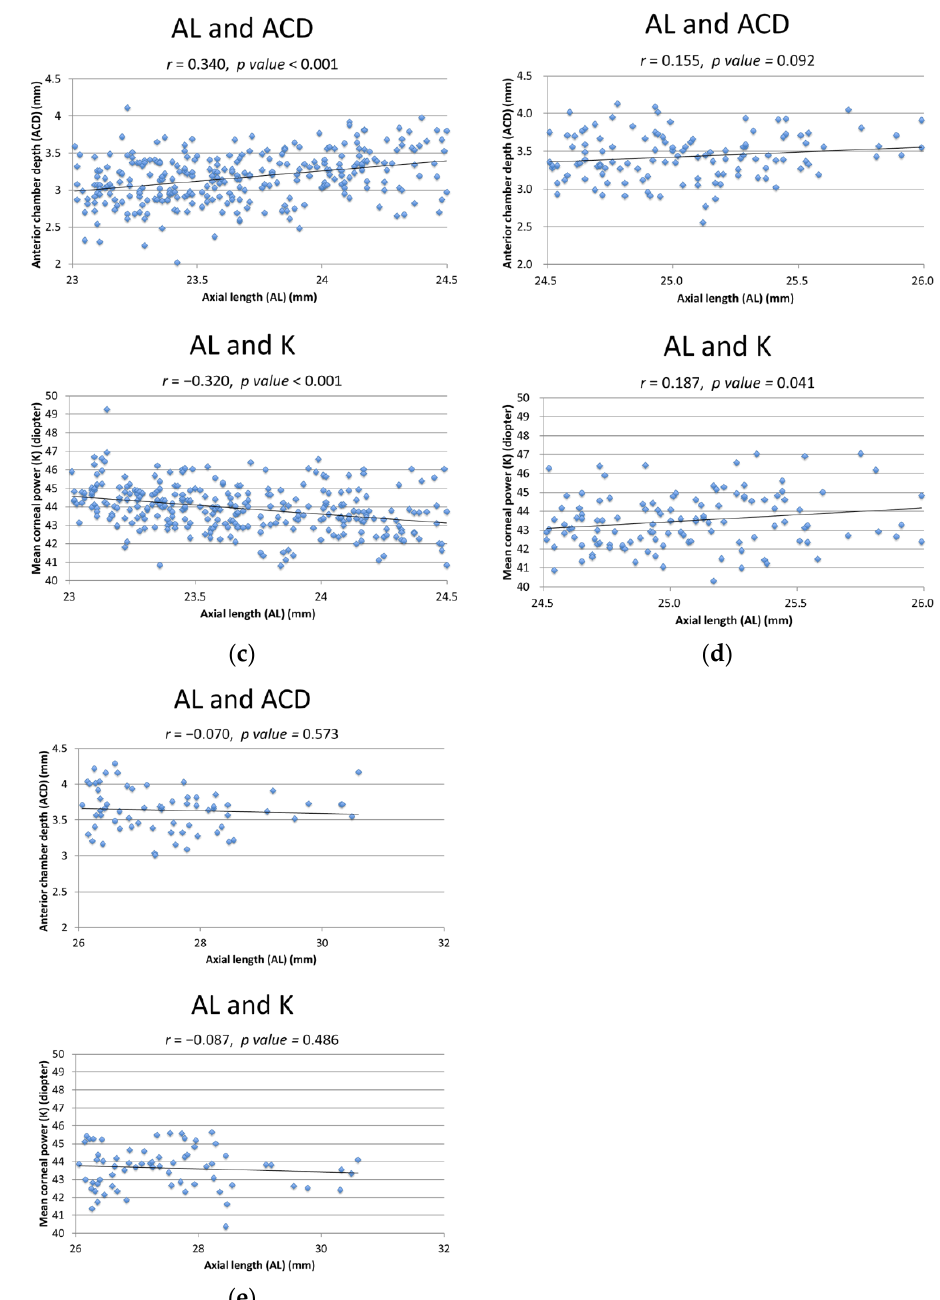
Figure 1. The relationships between axial length (AL) and other variables for structural equation models. ( a ) Total 621 eyes; ( b ) AL ≤ 23.0 mm; ( c ) 23.0 mm < AL ≤ 24.5 mm; ( d ) 24.5 mm < AL ≤ 26.0 mm; ( e ) AL > 26.0 mm. K = mean corneal dioptric power; ACD = anterior chamber depth.